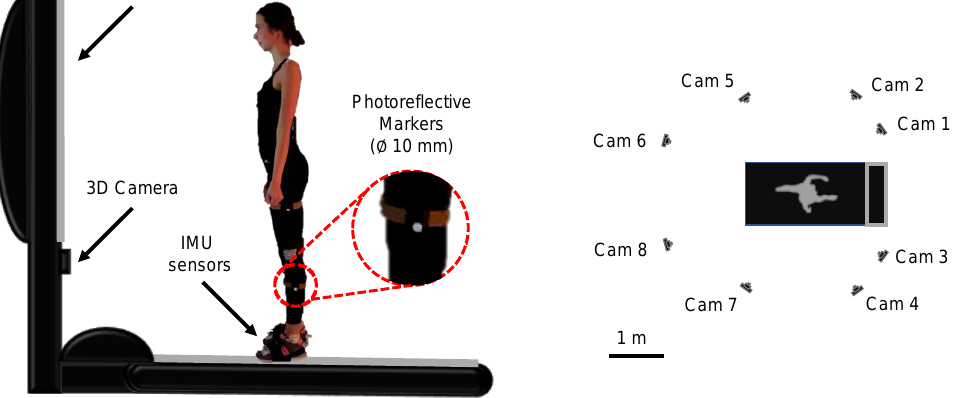
Figure 1. A schematic representation of the instrumented treadmill and of the participant with attached retro-reflective markers and IMU sensors at the foot level (on the left of the figure). A schematic representation of the camera positions around the treadmill (on the right of the figure).